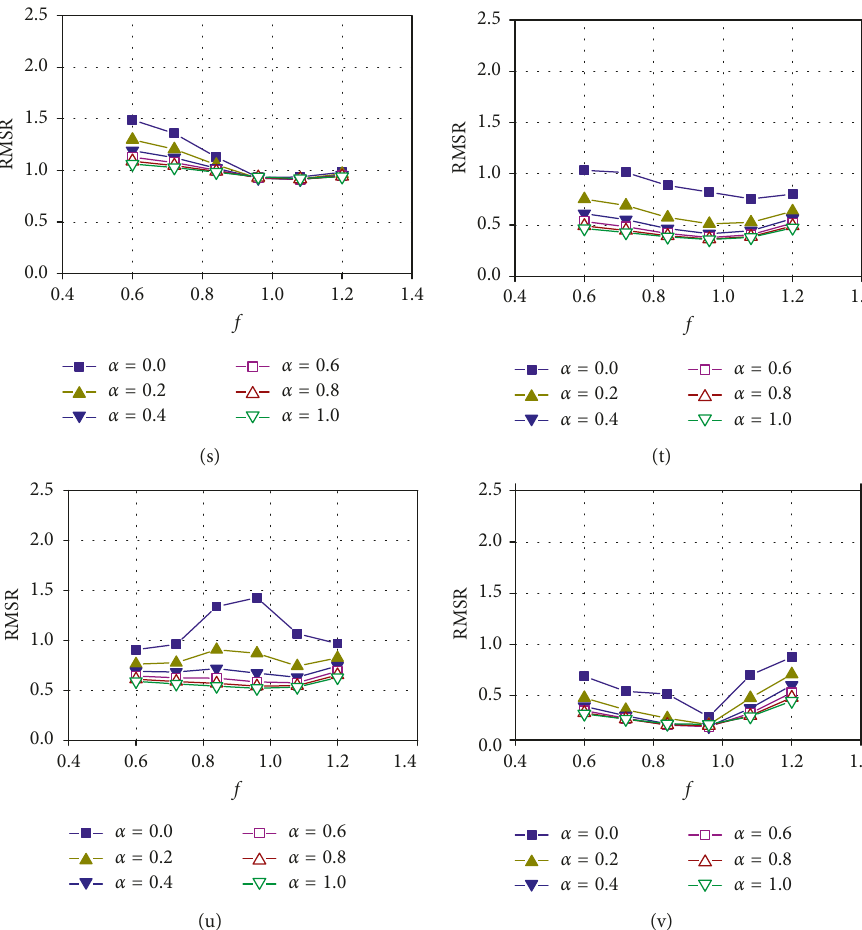
Figure 7: Relationships between RMSR, f , and α under different ground motions. (a) Northridge (NORTHR/MUL279), (b) D¨uzce Turkey (DUZCE/BOL090), (c) Hector mine (HECTOR/HEC090), (d) Imperial Valley (IMPVALL/H-DLT352), (e) Kobe (KOBE/SHI090), (f) Kocaeli Turkey (KOCAELI/DZC270), (g) Landers (LANDERS/YER360), (h) Loma Prieta (LOMAP/CAP090), (i) Manjil Iran (MANJIL/ABBAR-T), (j) Superstition Hills (SUPERST/B-POE360), (k) Cape Mendocino (CAPEMEND/RIO360), (l) Chi-Chi (CHICHI/TCU045-N), (m) San Fernando (SFERN/PEL180), (n) Friuli Italy (FRIULI/A-TMZ270), (o) Northridge (NORTH- R/LOS270), (p) Imperial Valley (IMPVALL/H-E11230), (q) Kobe (KOBE/NIS090), (r) Kocaeli Turkey (KOCAELI/ARC090), (s) Landers (LANDERS/CLW-TR), (t) Loma Prieta (LOMAP/G03090), (u) Superstition Hills (SUPERST/B-ICC090), and (v) Chi-Chi